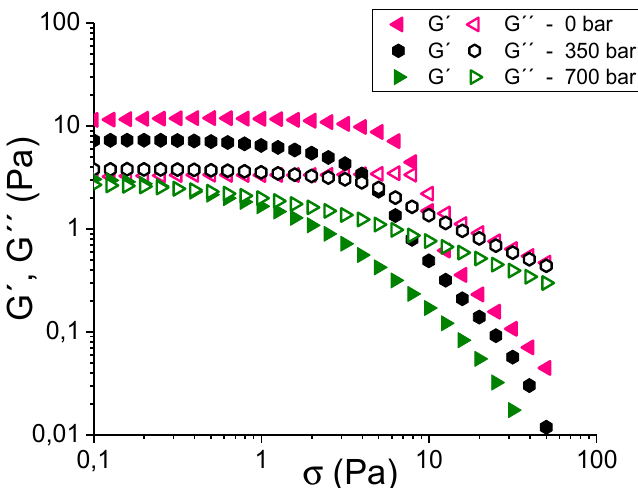
Figure 6. Stress sweeps for thyme emulsions studied containing 0.4 wt % of rhamsan gum as a function of the homogenization pressure applied in the microfluidizer.